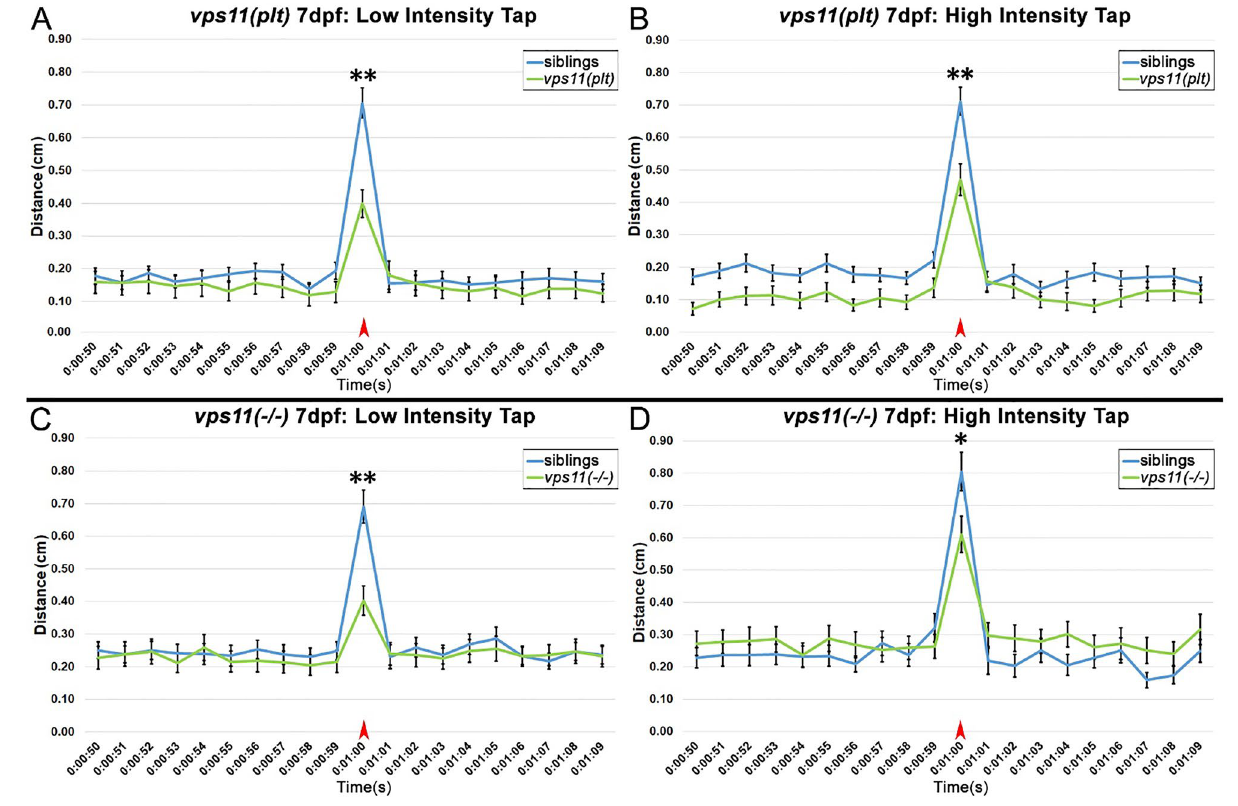
Figure 6. vps11(plt) and vps11 (−/−) mutants at 7dpf show significantly reduced distance travelled in response to both low and high intensity acoustic/tap stimuli. ( A – D ) Line graphs representing distance travelled by larvae at 7dpf before and after an acoustic/tap stimulus (red arrow). ( A ) Response of vps11(plt) (green; n = 69) and sibling larvae (blue; n = 77) to a low intensity stimulus. ( B ) Response of vps11(plt) (green; n = 71) and sibling larvae (blue; n = 73) to a high intensity stimulus. ( C ) Response of vps11 (−/−) (green; n = 54) and sibling larvae (blue; n = 54) to a low intensity stimulus. ( D ) Response of vps11 (−/−) (green; n = 48) and sibling larvae (blue; n = 47) to a high intensity stimulus. * P < 0.05 ** P < 0.01. Error bars indicate